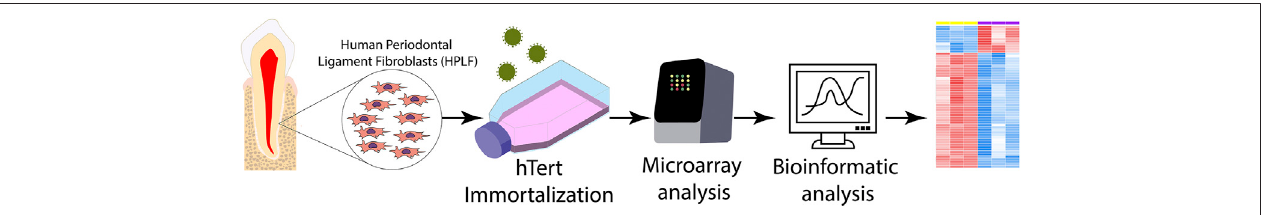
FIGURE 1 | Methodological scheme of the experimental design. The primary culture of human periodontal ligament fi broblasts (hPLF) was immortalized by the telomerase reverse transcriptase enzyme (hTERT) protocol, and then the transcriptome analysis through microarray was performed using bioinformatics